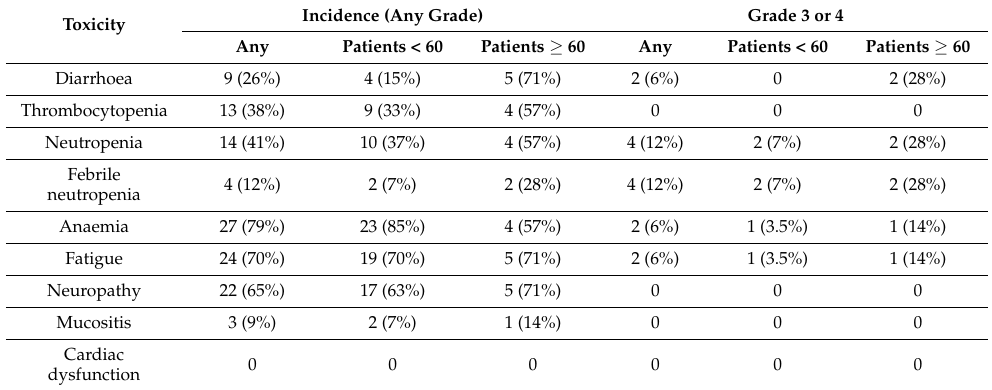
Table 2. Treatment toxicity.